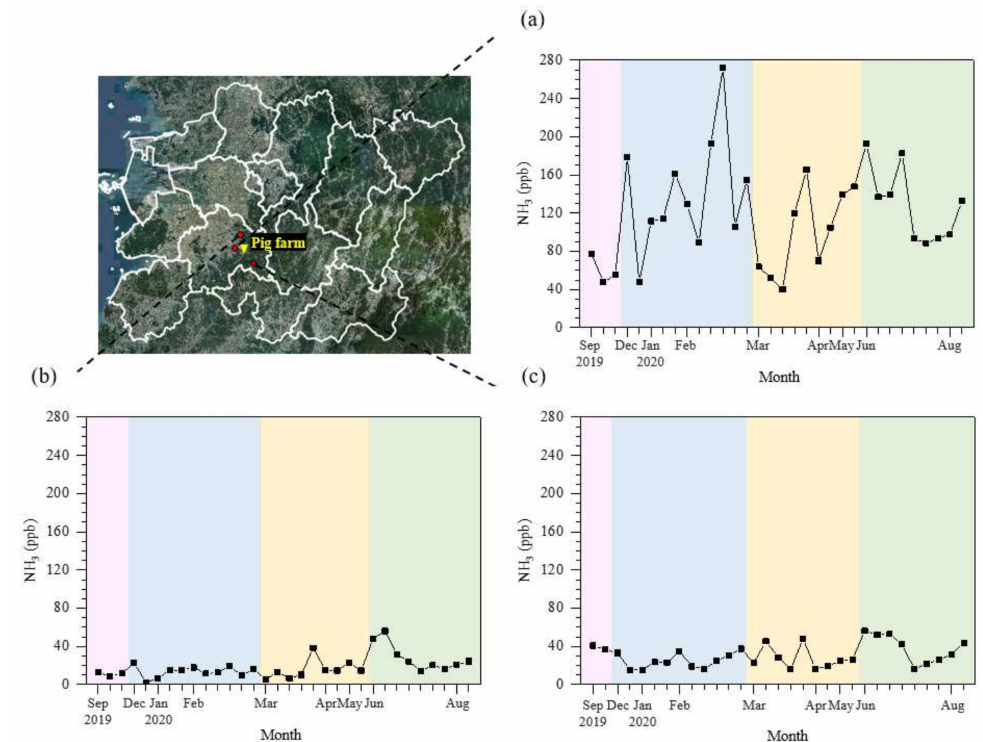
Figure 2. Sample-specific concentrations of atmospheric NH 3 collected by passive samplers at three different locations in the rural area: ( a ) R1, ( b ) R2, and ( c ) R3. Pink region: autumn; blue region: winter; yellow region: spring; and green region: summer. The yellow triangle indicates the location of the target pig